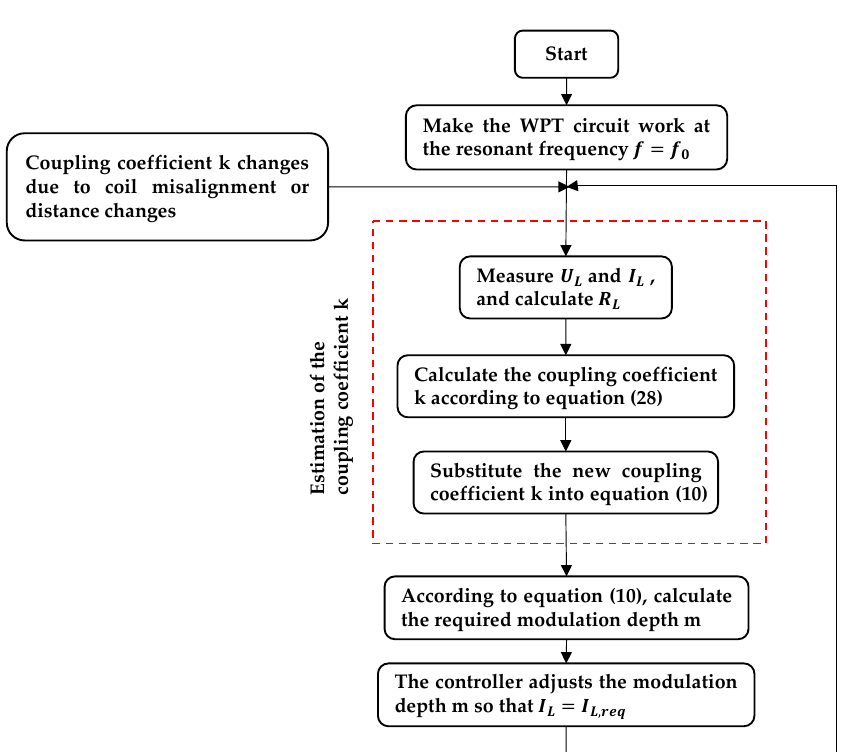
Figure 7. Flow chart of modulation depth adjustment based on coupling-coefficient estimation in CC mode.